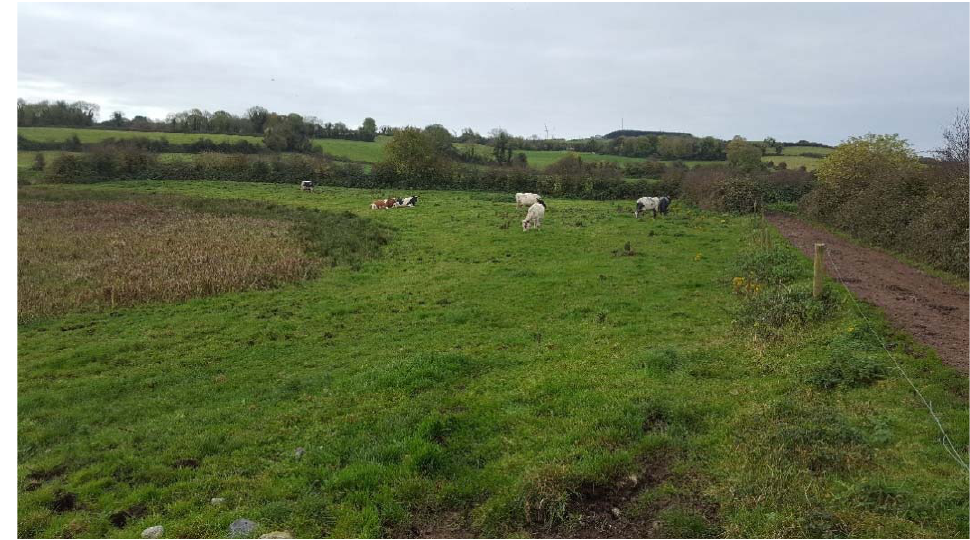
Figure A1. Site FF, looking west. The low ridge in the background is underlain by Clare Shales. The marshy ground to the left is the location of the soils with the highest selenium values. The grassed areas were much lower in selenium, and it decreased to background levels up the slope to the right, by the path.